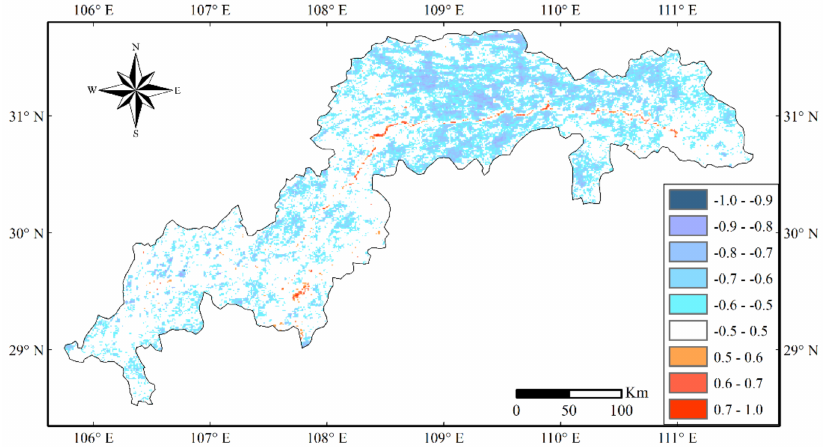
Figure 11. Spatial distribution of correlation coe ffi cients between Seasonally Integrated Normalized Di ff erence Vegetation Index (SINDVI) and land surface temperature (LST). The colored regions are characterized by a 95% confidence interval, while the areas are shown in white with P values higher than 0.05. Positive values mean positive correlation, while negative values mean negative